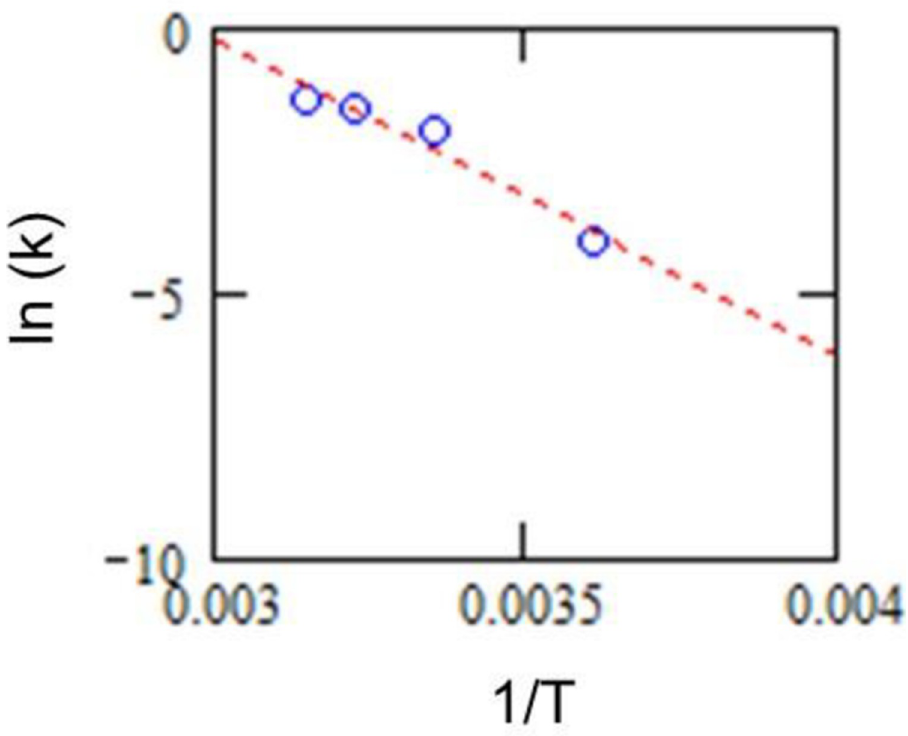
Fig 5. Relationship between the logarithm of reaction rate constant k and the inverse of temperatures T